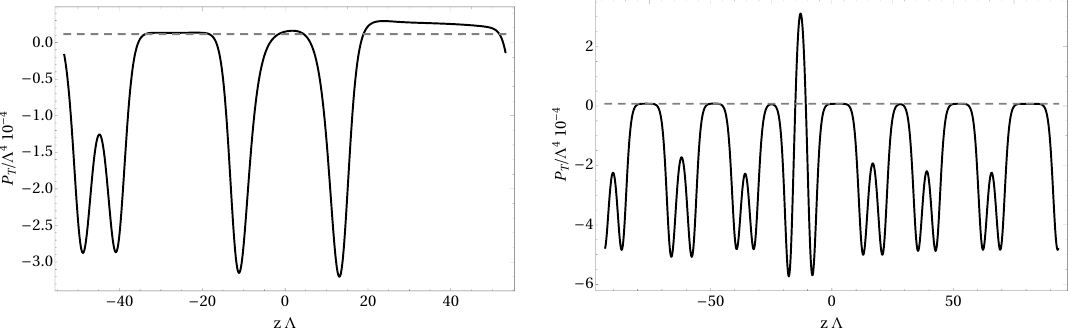
Figure 4 . Transverse pressure P L longitudinal profile during reshaping as the solid black line and the critical pressure P c as the dashed gray line (left) with φ M = 2 . 35 at t Λ = 1200 forming a peak, two valleys and a plateau of the simulation visualized on top right of figure 8 (right) with φ M = 2 . 3 at t Λ = 1180 forming several peaks, a single plateau, and valleys in between of the simulation visualized on the left figure